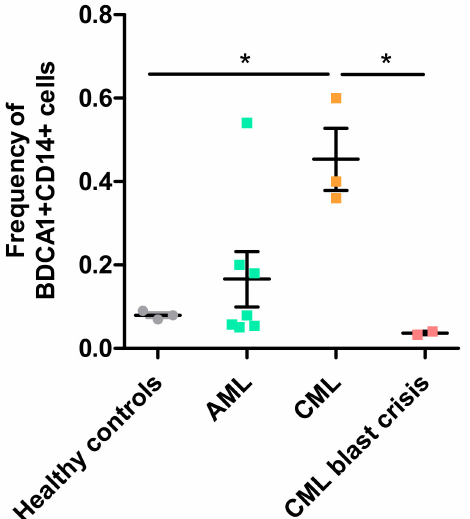
Figure 1. Frequency of BDCA1+CD14+ cells in peripheral blood mononuclear cells (PBMCs) of leukemia patients. Frequency of cells was analyzed by flow cytometry in PBMCs of healthy controls ( n = 3) and patients with acute myeloid leukemia (AML; n = 7), chronic myeloid leukemia (CML; n = 3) or a CML blast crisis ( n = 2). Each dot represents PBMCs of a single patient. Mean ± SD. * p < 0.05%; One-Way ANOVA with Tukey’s multiple comparison